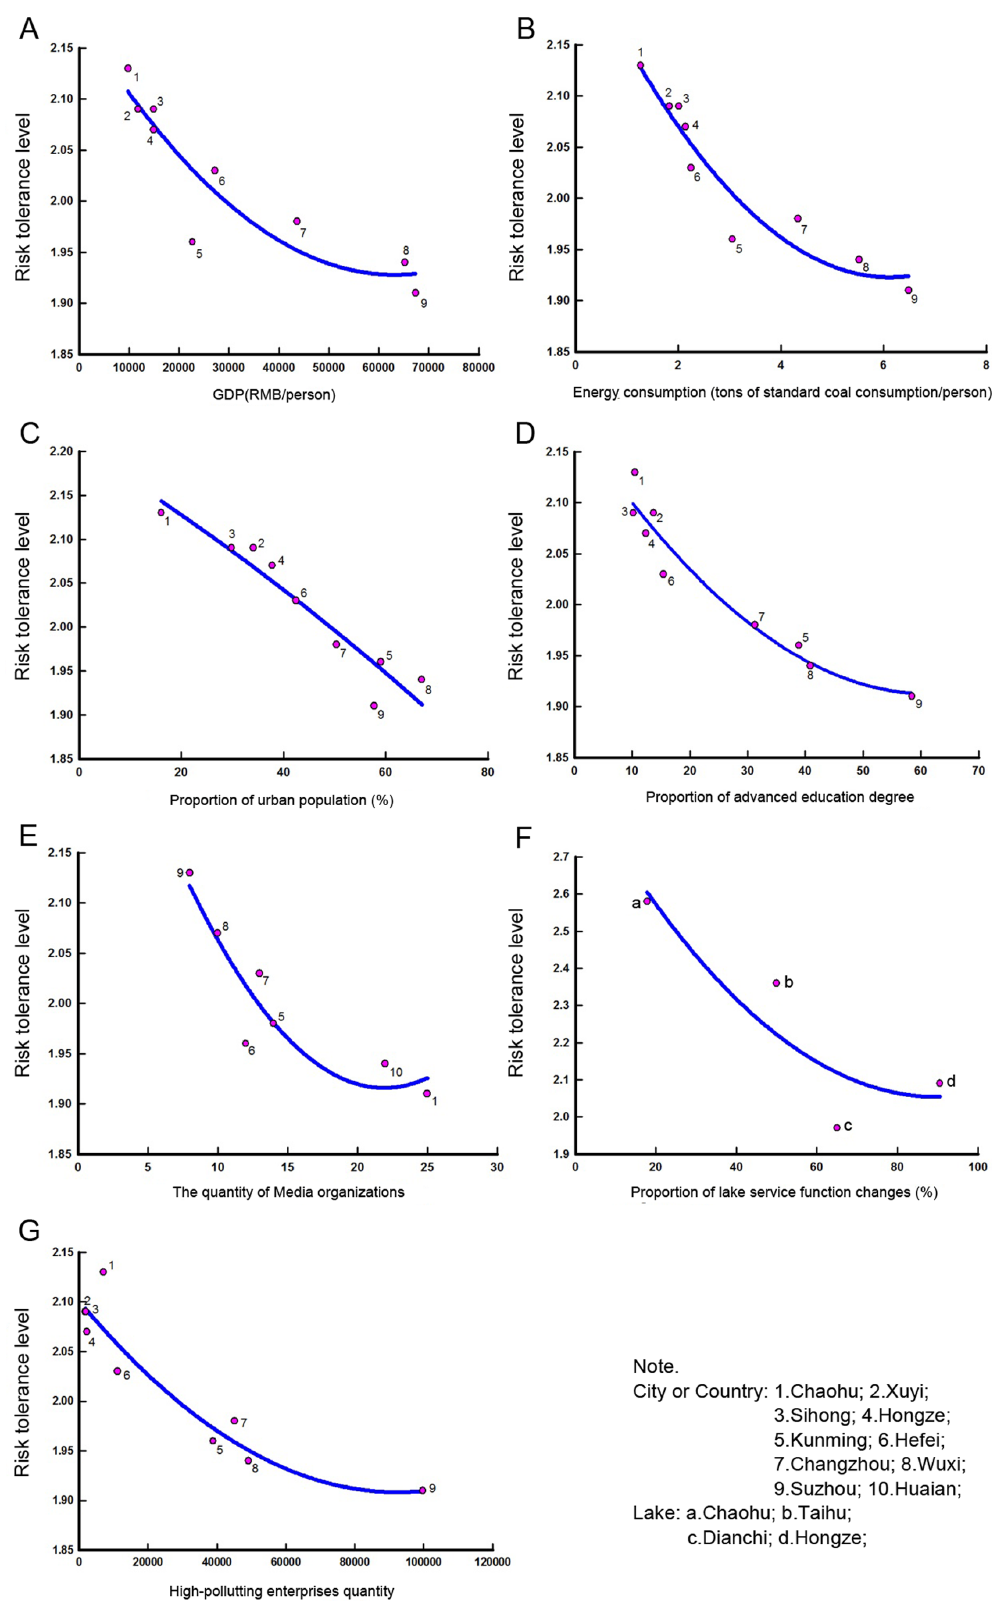
Figure 4. Regression analysis between social indicators and risk tolerance levels of HABs.